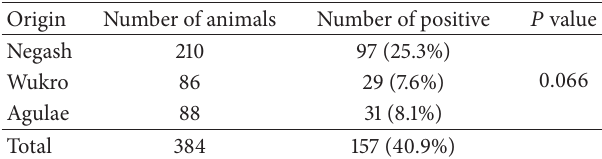
Table 4: Prevalence of Haemonchus in sheep based on the